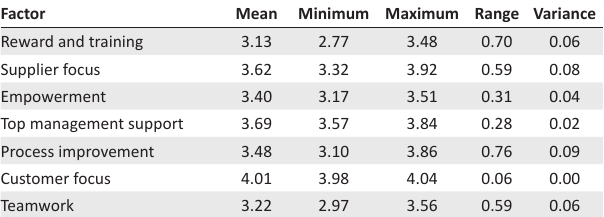
TABLE 5: Descriptive statistics of the dimensions of total quality